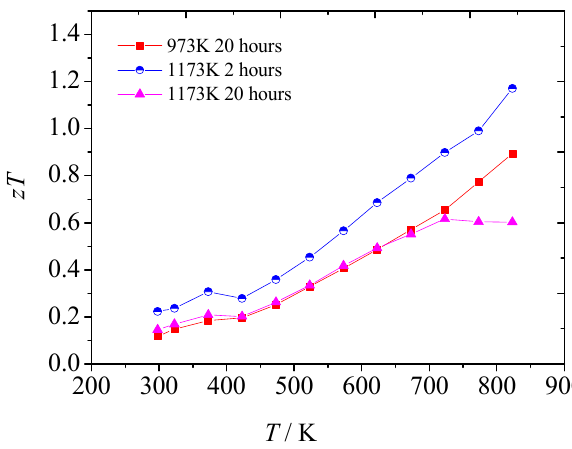
Figure 5. zT values for the Cu 2 Se samples sintered under different conditions.